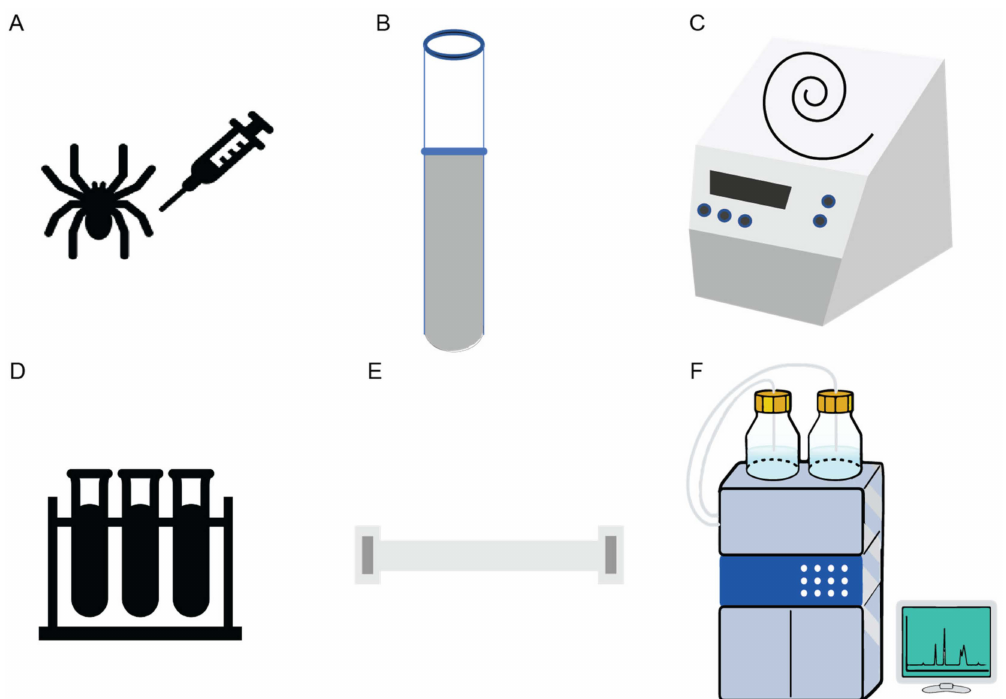
Figure 3. Schematic illustration of the isolation of Gm from spiders, hemolymph collection, and peptide extraction and purification. ( A ) Hemolymph collection from a spider is typically performed in sodium citrate buffer (pH 4.6). ( B ) Hemocytes are collected from the hemolymph. ( C ) Concentration and pyrolysis steps are done using vacuum centrifugation. ( D ) Solid phase extraction using pre- purified supernatant from ultrasonic treatment is then applied. ( E ) Aquapore RP-300 C 8 column for peptide elution. ( F ) Further purification of the active peptide through high performance liquid chromatography-size exclusion column (HPLC-SEC 1 ) completes the process